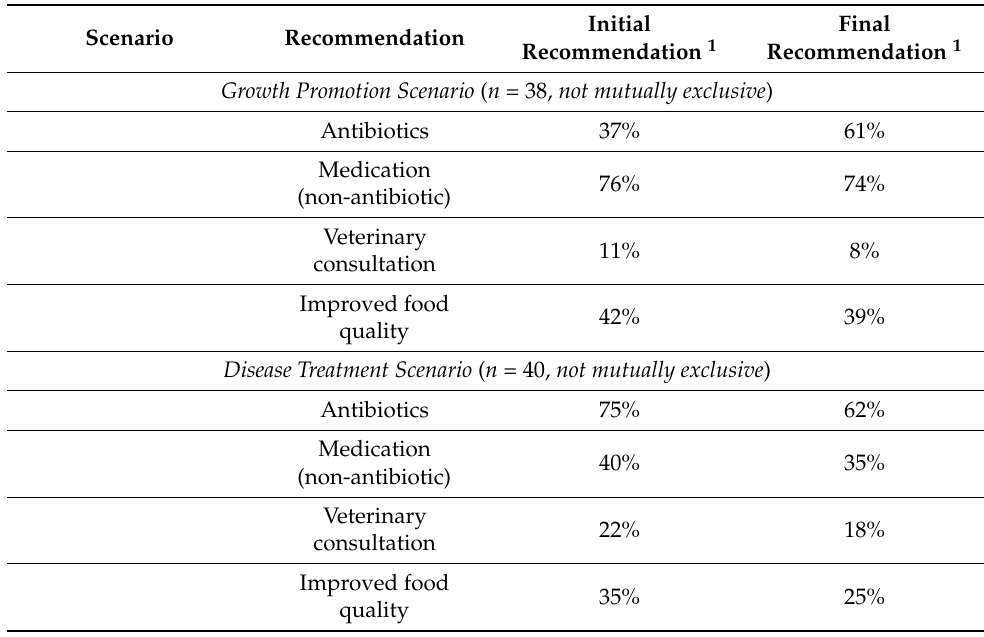
Table 3. Proportion of sales agents’ initial and final recommendations by the two simulated client method